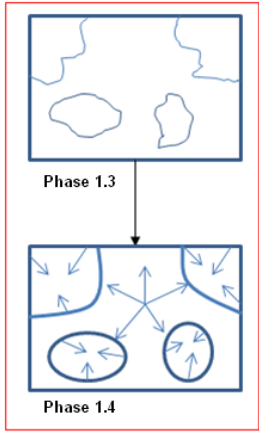
Figure 6. Interrelationship between phases 1.3 and